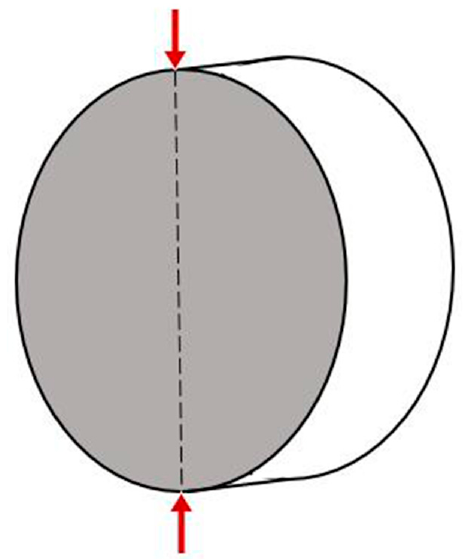
Figure 7. Finite element calculation model.